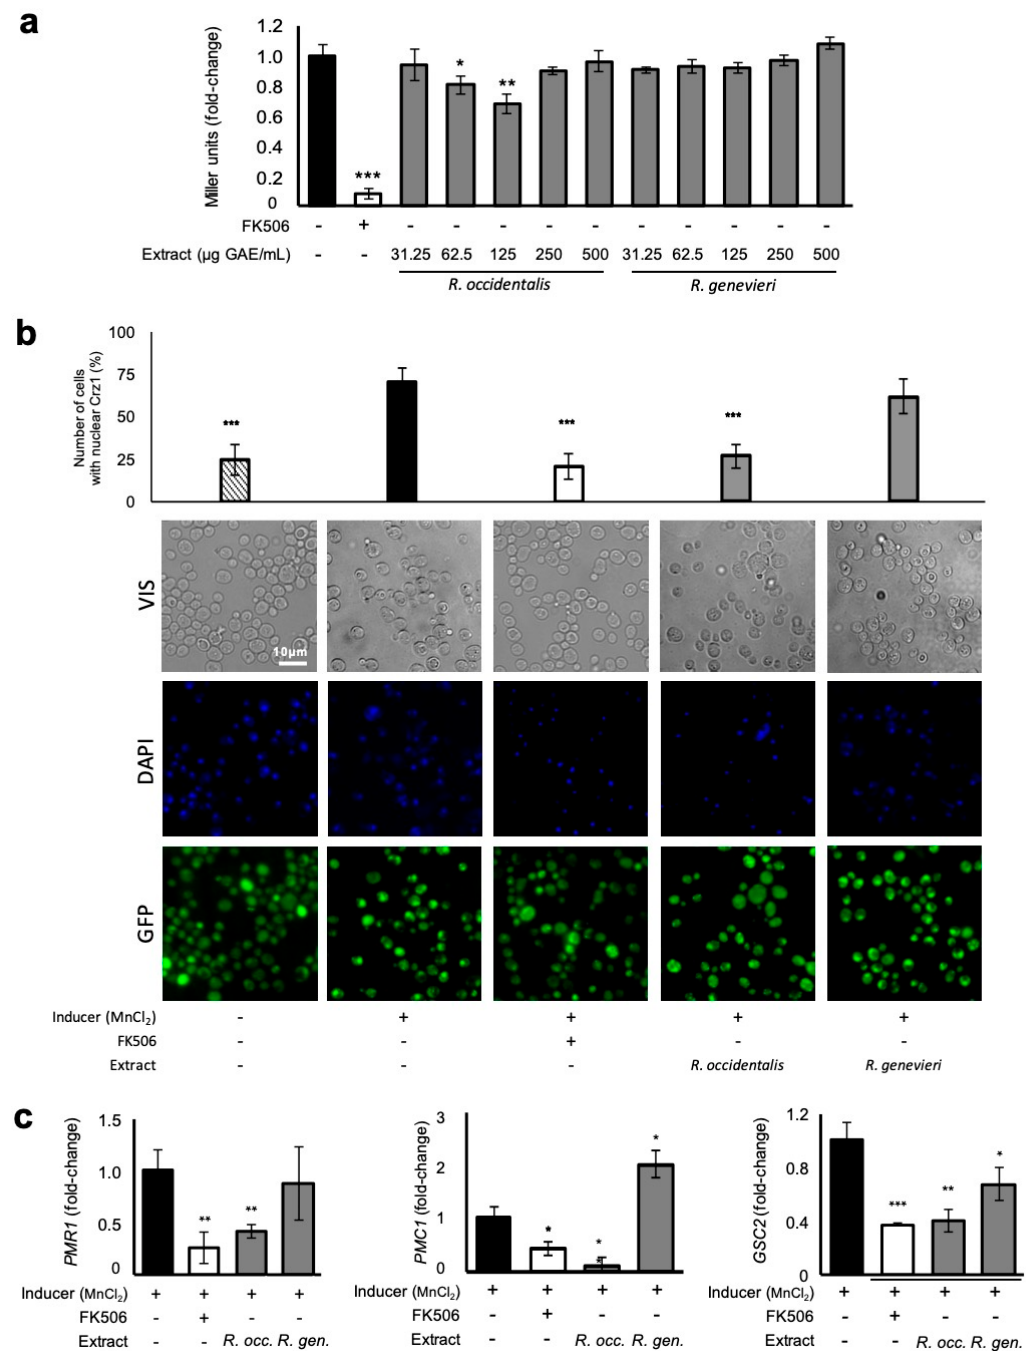
Figure 4. Attenuation Crz1 activation by Rubus occidentalis (var. Huron). BY4741 yeast strains encoding CRZ1 promoter –lacZ or CRZ1–GFP were subjected or not to the indicated concentrations of phenolic compounds-enriched extracts and induced with 1.8 mM MnCl 2 . ( a ) Crz1 activation was assessed by monitoring β -galactosidase activity using 2-Nitrophenyl β - d -galactopyranoside (ONPG). ( b ) Crz1 subcellular dynamics evaluated by fluorescence microscopy in cells treated with 125 µ g GAE / mL of the indicated phenolic compounds-enriched extracts. ( c ) Activation of Crz1 target genes PMR1 , PMC1 , and GSC2 in cells treated as above by means of qRT-PCR. The immunosuppressant FK506, which inhibits calcineurin and prevents Crz1 activation, was used as a positive control. Representative images are shown, and the values represent the mean ± SEM of at least three biological replicates, * p < 0.05, ** p < 0.01, *** p < 0.001.